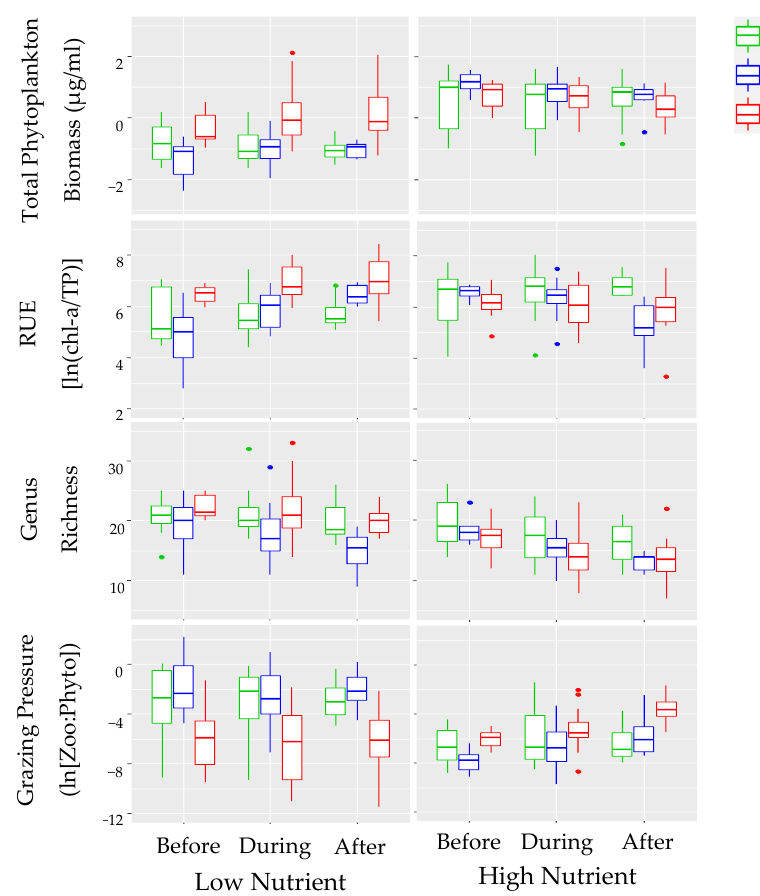
Figure 3. Total phytoplankton biomass (Box-Cox power transformation was applied), RUE, phytoplankton genus richness, and zooplankton grazing pressure for all treatments in all periods. Left panel is LN, right panel is HN (boxplots are presented with medians and ‘hinges’ are versions of the first and third quartiles).